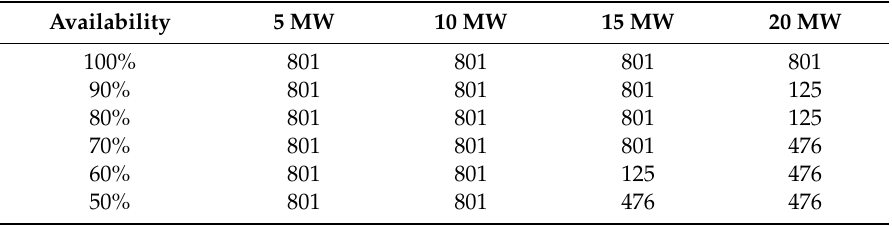
Table 5. Optimal locations at a range of capacities and reduced biomass availability.